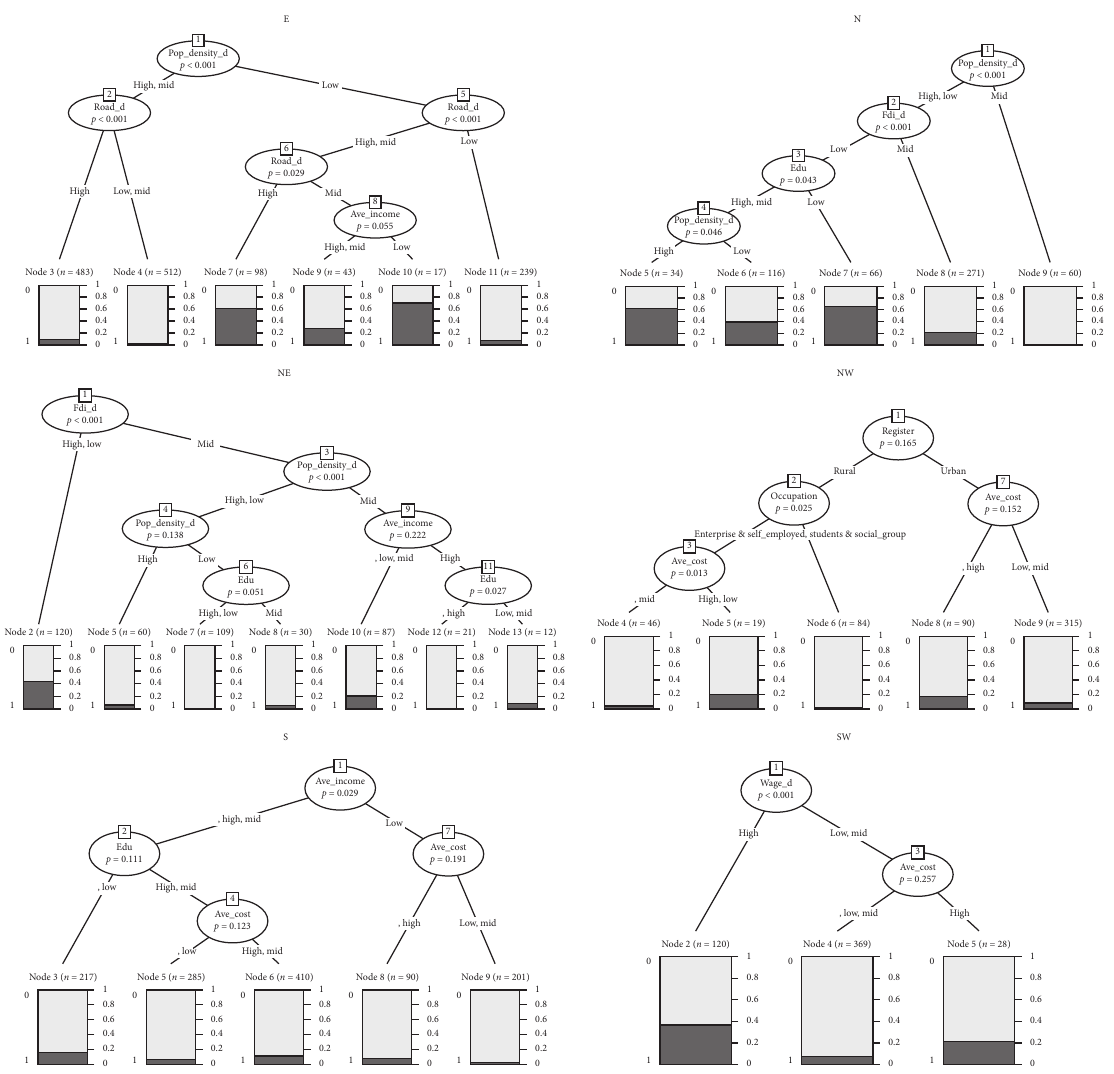
Figure 9: Conditional inference tree of six geographical